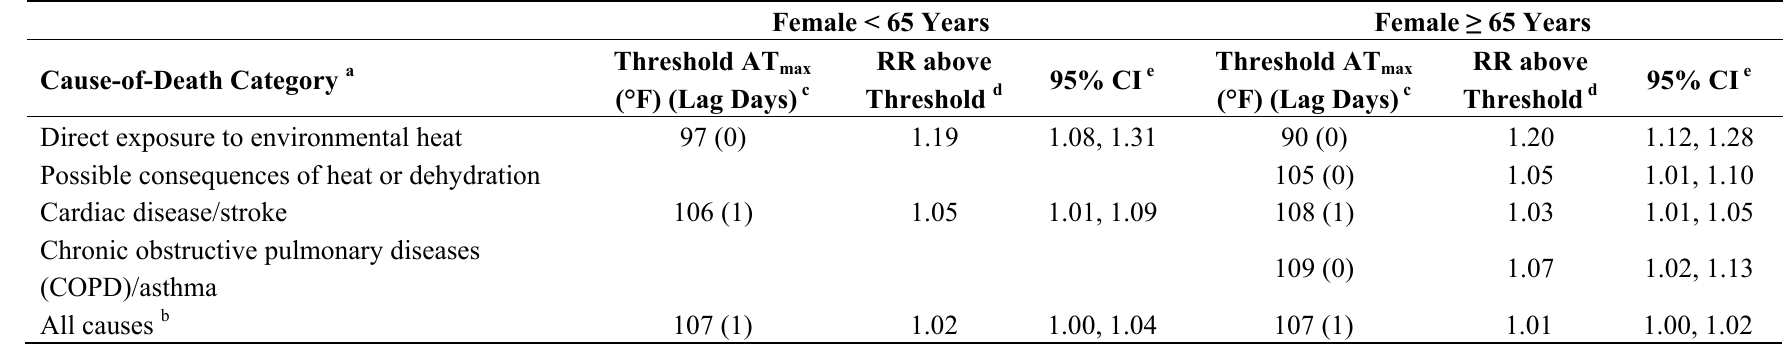
Table 5. Deaths in Maricopa County female residents ages <65 years and ≥ 65 years directly caused by exposure to environmental heat and other causes potentially related to high temperatures during the months May–October for years